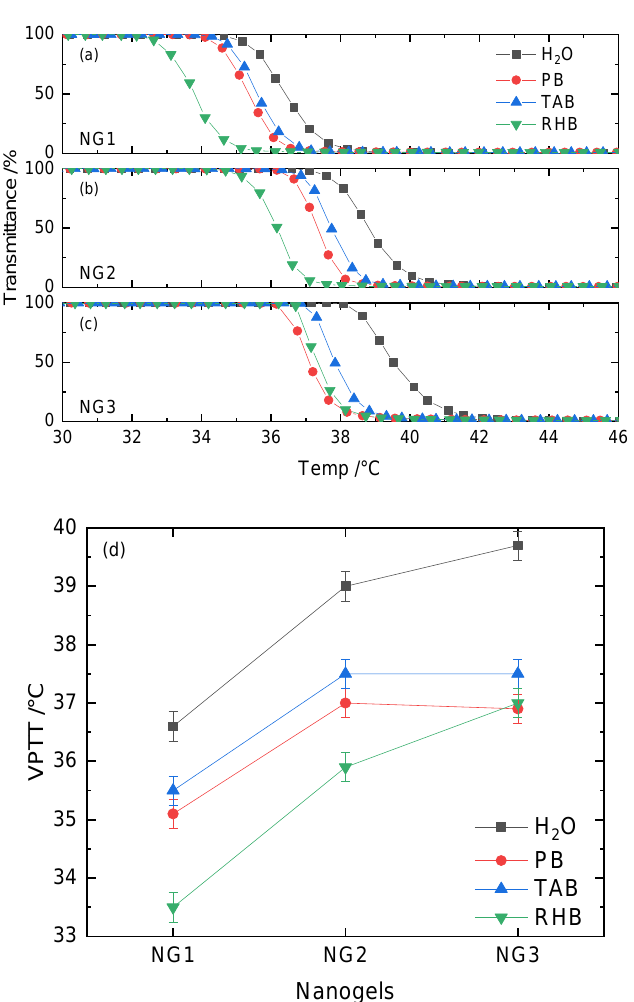
Figure 2. Volume phase transition temperature (VPTT) profiles of ( a ) NG1, ( b ) NG2 and ( c ) NG3 in H 2 O, phosphate buffer (PB), tris-acetate buffer (TAB) and Ringer HEPES buffer (RHB). Their corresponding VPTT values are summarized in ( d ).